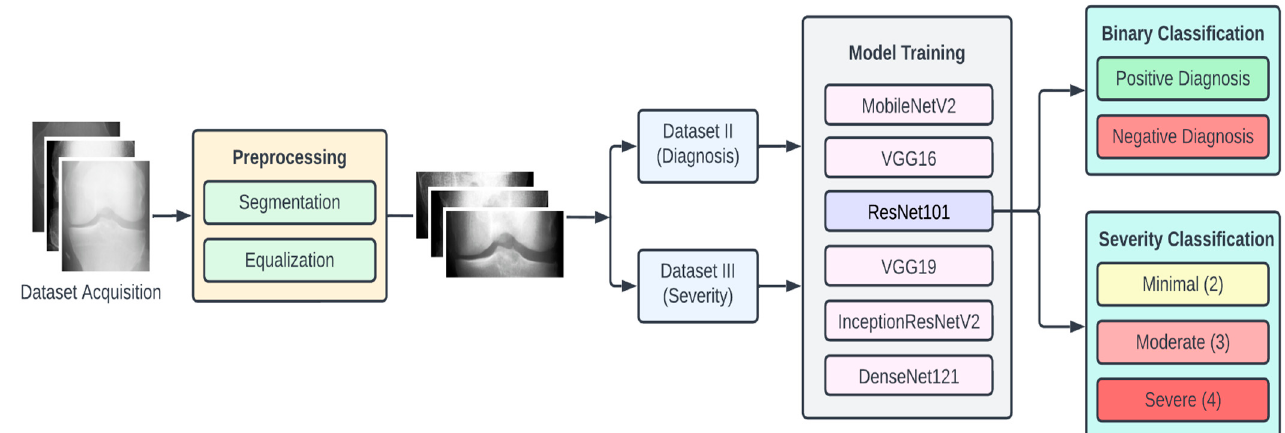
Figure 1. Proposed approach for KOA detection and classi fi cation.